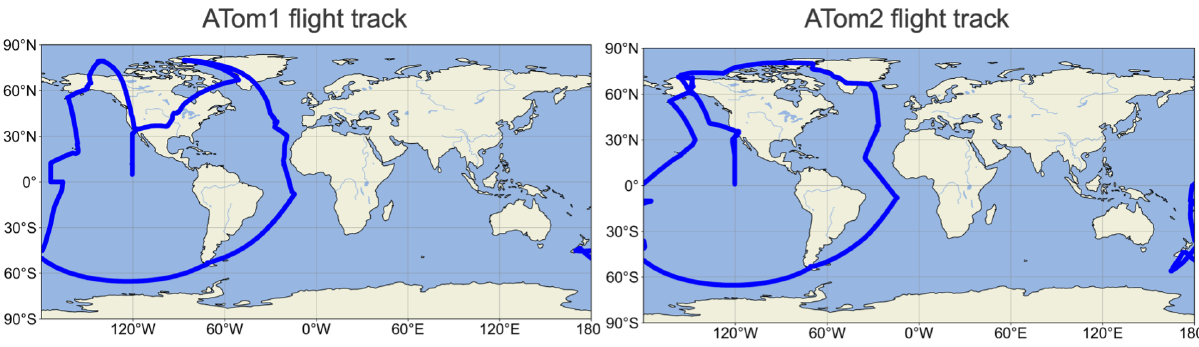
Figure 1. ATom1 and ATom2 flight